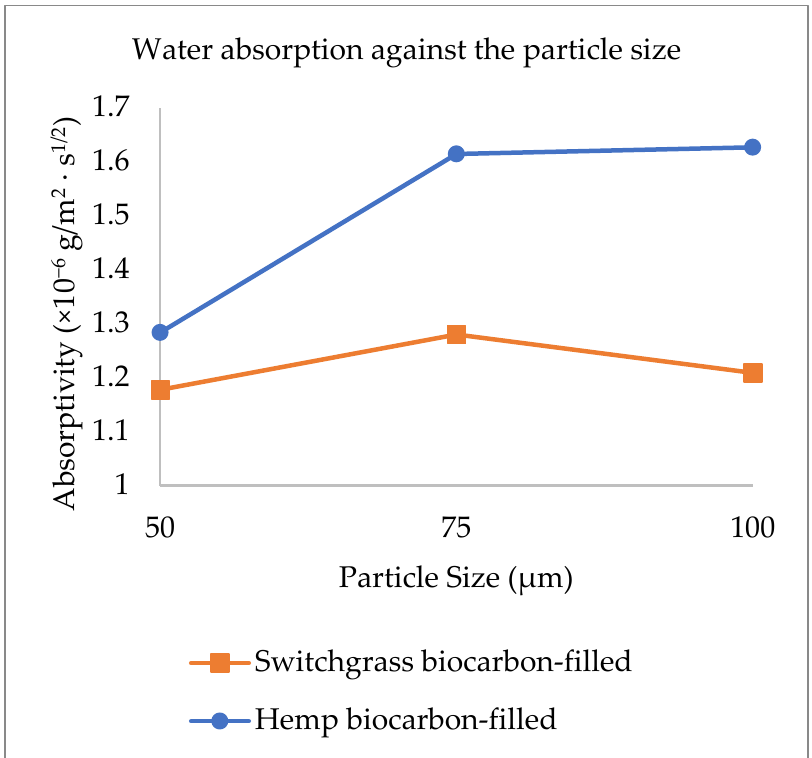
Figure 13. Main effect of the filler particle size on the water absorptivity.